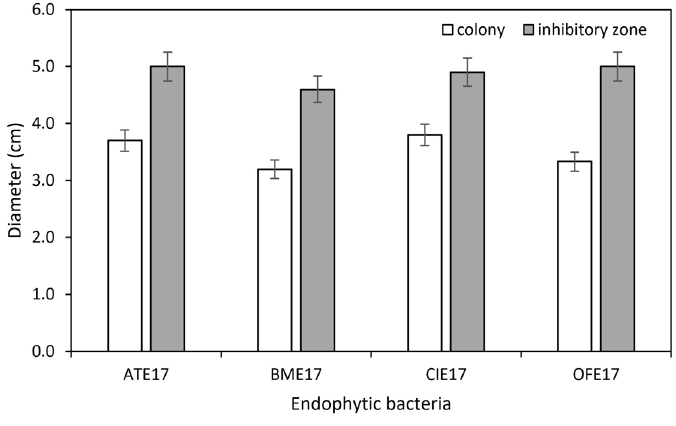
Fig. 2. Inhibitory zone size of four endophytes against Xaj DW3F3 on YPGA